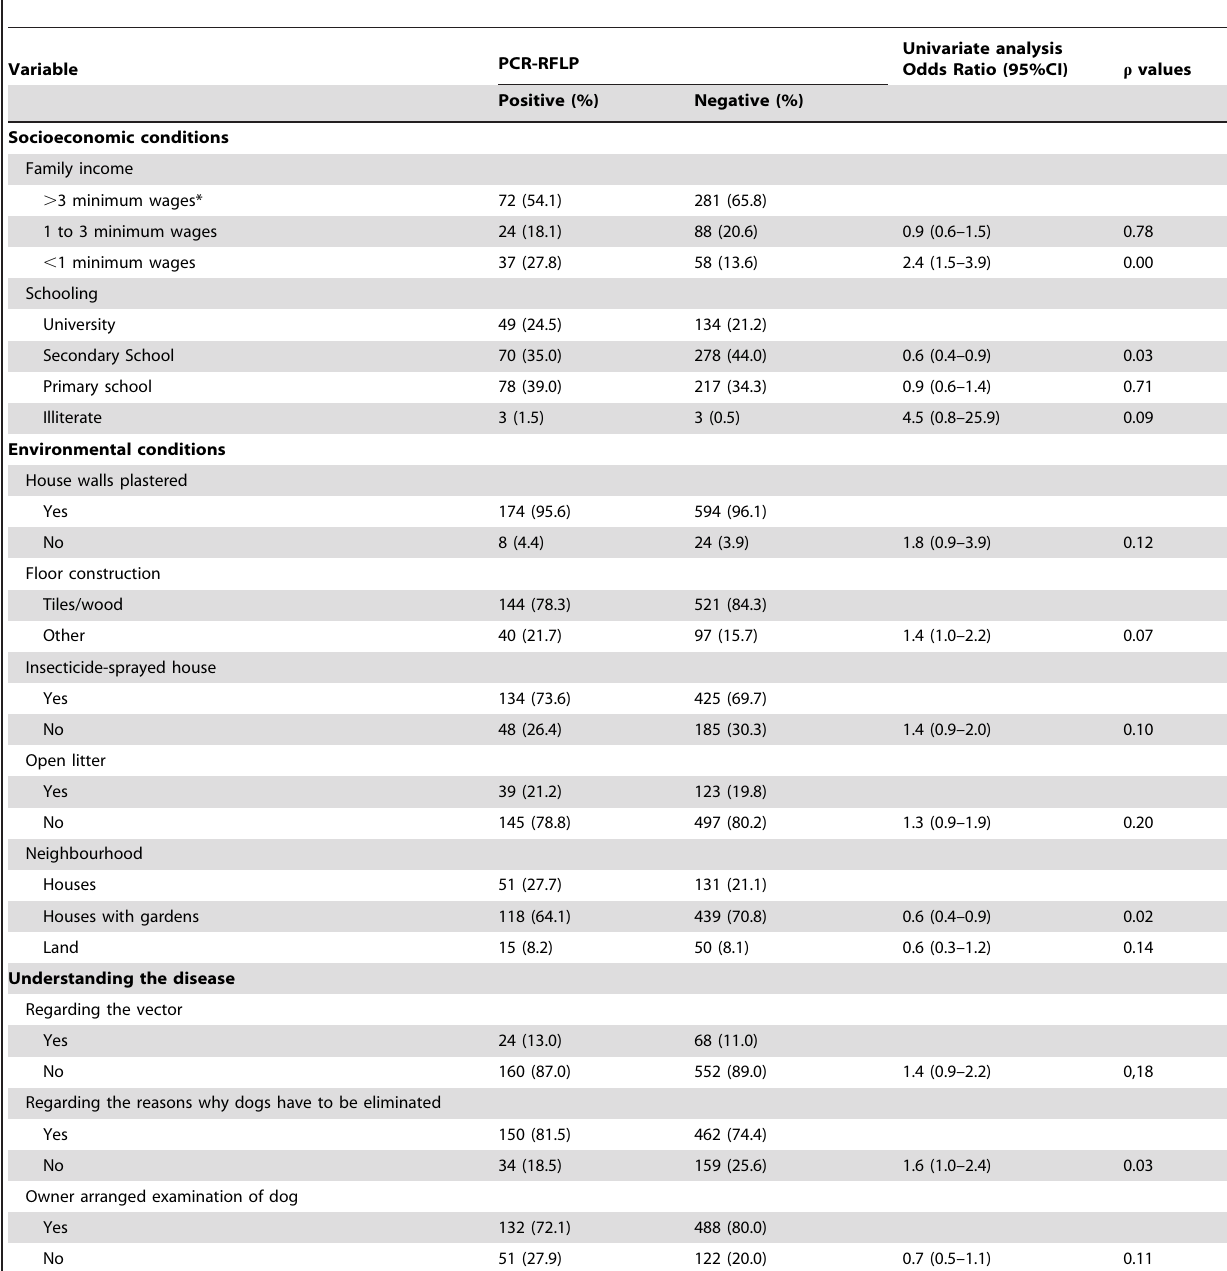
Table 2. Distribution of owners ( n = 918) of seronegative dogs according to the socioeconomic and environmental conditions and understanding of the disease, Brazil